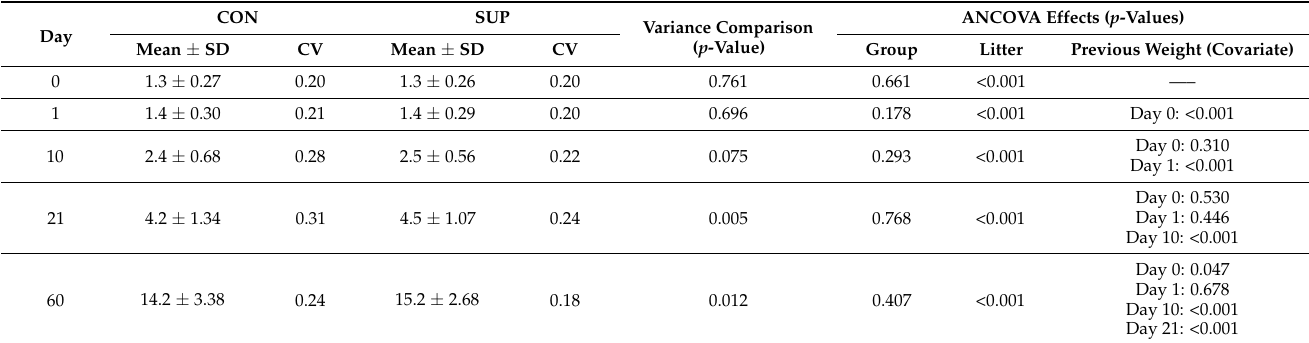
Table 2. Weights (kg) for survivor piglets for days of age 0–60 from the CON ( n = 166) and SUP ( n = 159) groups. SD: Standard deviation. CV: Coefficient of variation. CON: control group; SUP: colostrum supplemented group.